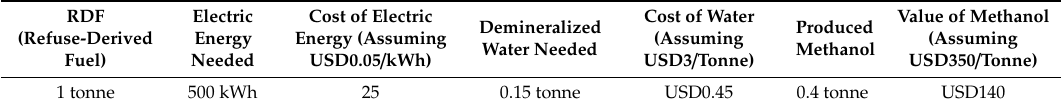
Table 2. Key process information.